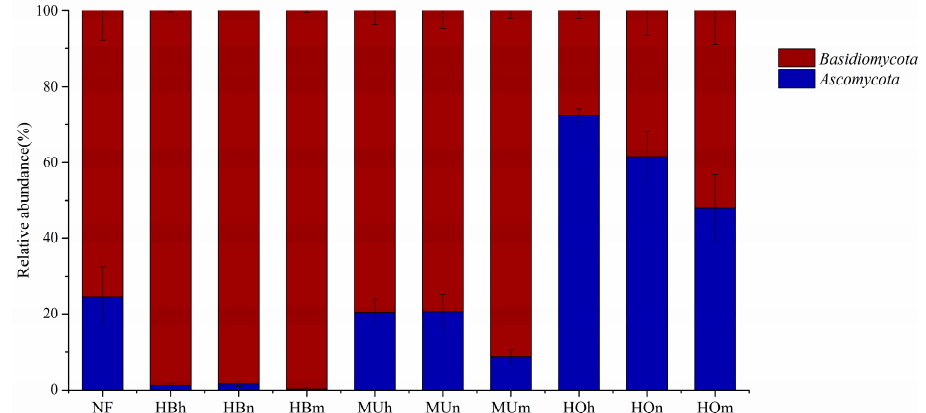
Figure 4. Relative abundance of EM fungal phyla in each P. sylvestris stand across three sandy lands